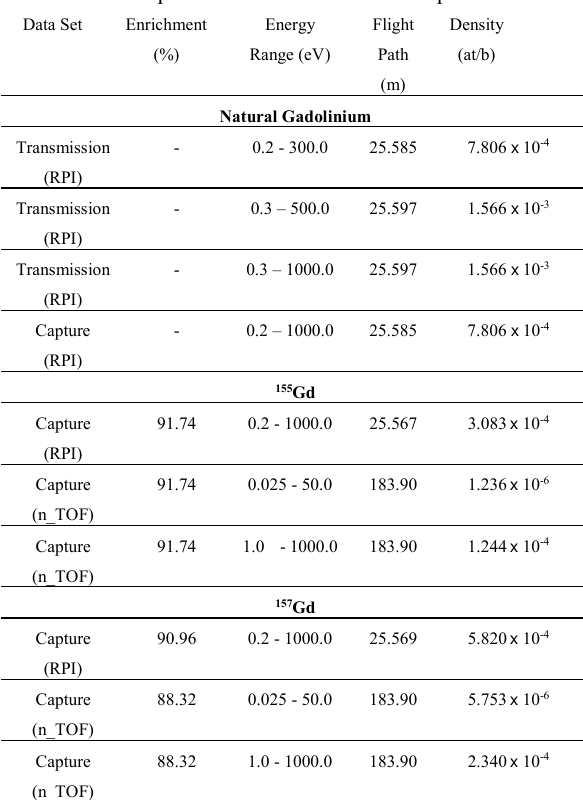
Table 2. Experimental transmission and capture data